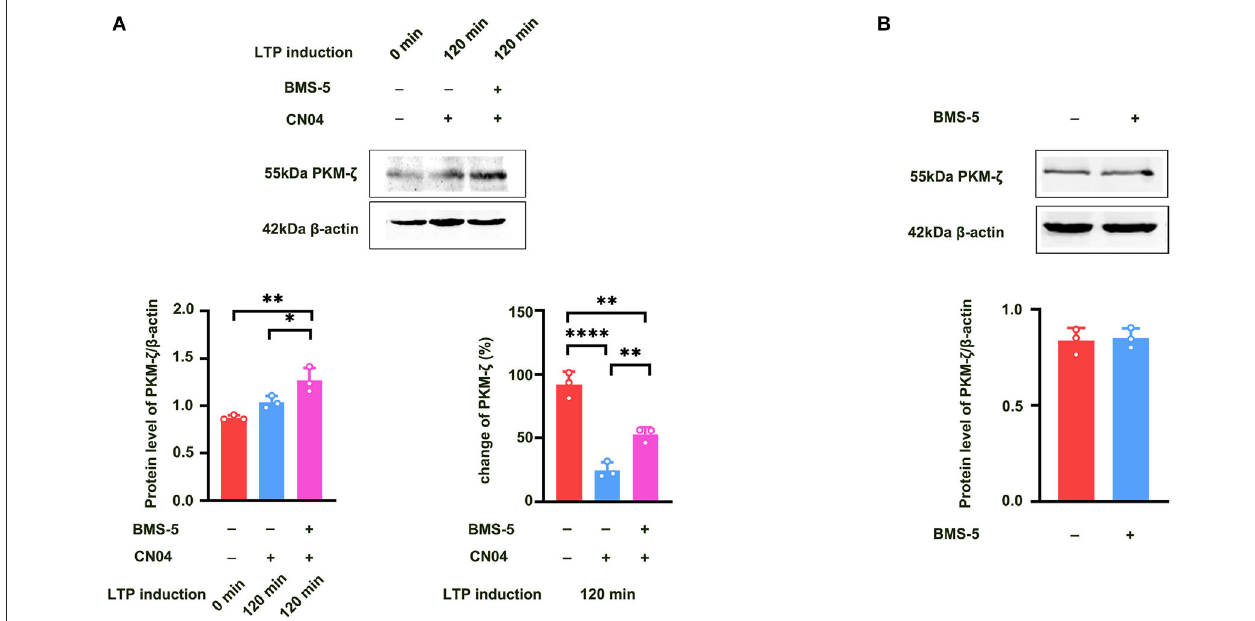
FIGURE 6 | Influence of LIMK inhibitor BMS-5 on Rac1-induced decrease in the expression of PKM ζ . (A) Influence of LIMK inhibitor BMS-5 (100 µ M) on the effects of Rac1 agonist CN04 (424nM) on PKM ζ expression at 120min after giving HFS (Bottom left: one-way ANOVA, * P < 0.05, ** P < 0.01, n = 3 in each group). Bottom right: The bar graph shows the change of PKM ζ expression from 0min to 120min after LTP induction (one-way ANOVA, ** P < 0.01, **** P < 0.0001, n = 3 in each group; The control group data is calculated using the data of Figure 5A ). (B) Influence of LIMK inhibitor BMS-5 (100 µ M) on PKM ζ expression (unpaired t- test, P > 0.05, n = 3 in each group). All data are shown as mean ±